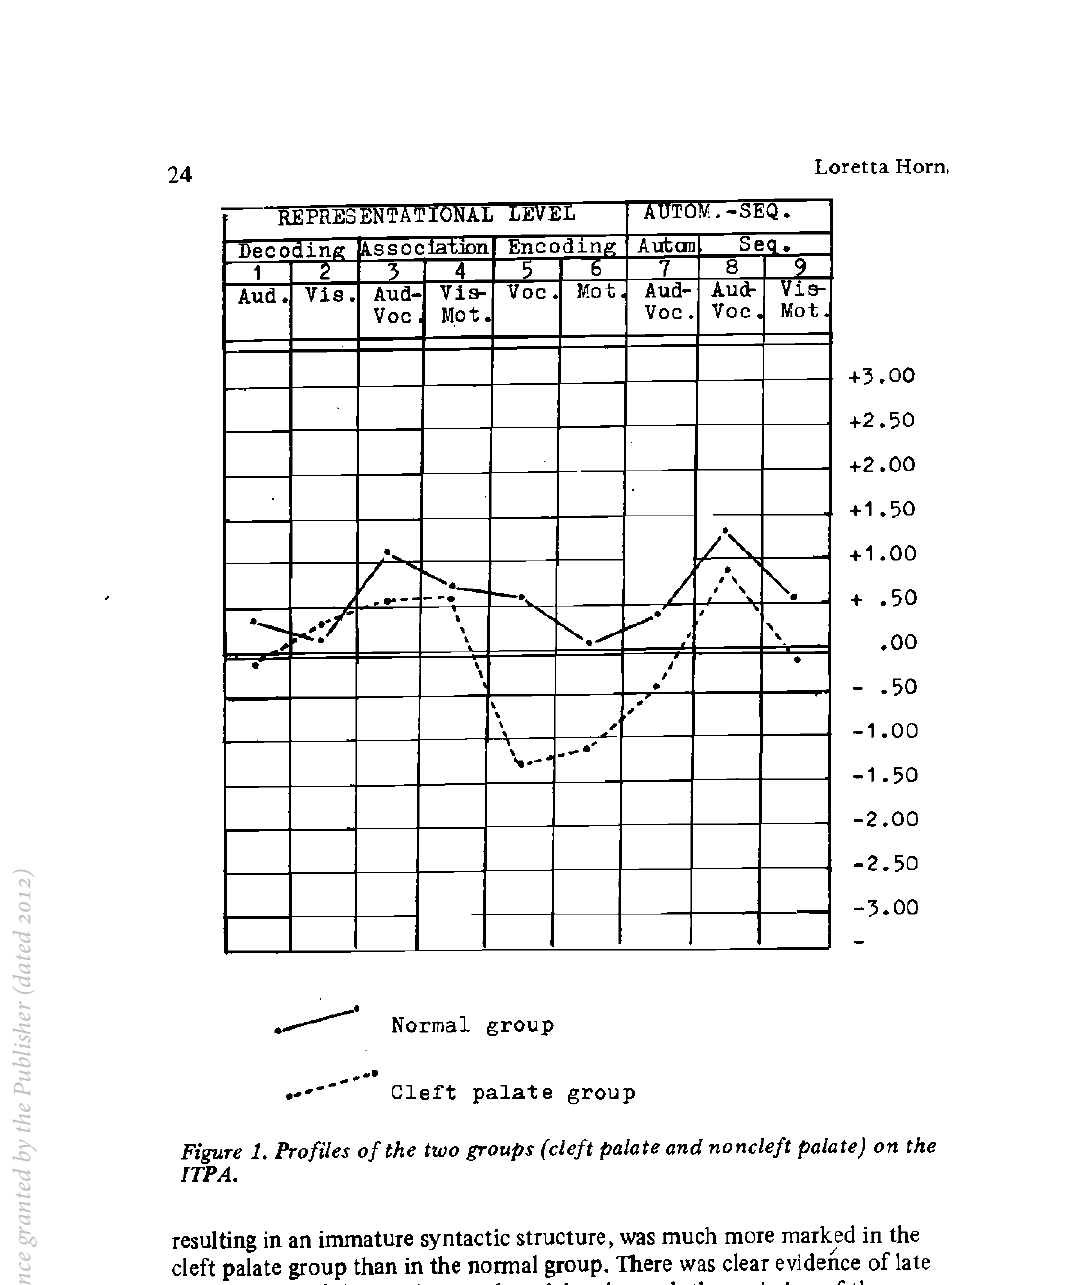
Figure 1. Profiles of the two groups (cleft palate and noncleft palate) on the